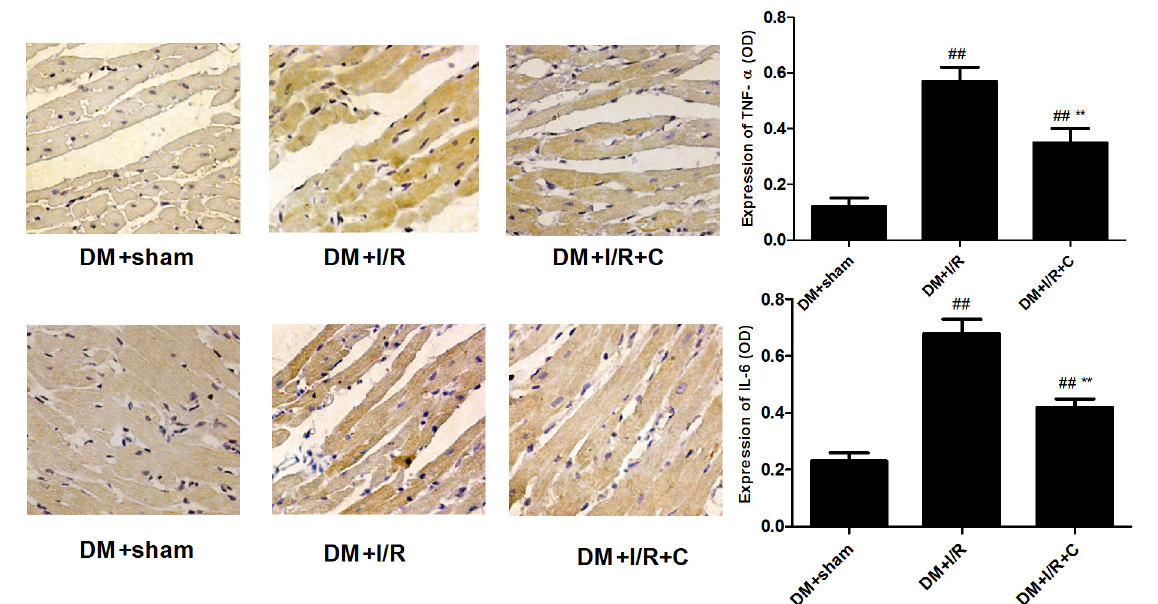
Figure 7. Effects of catalpol on protein expression of inflammatory cytokines ( TNF-α and IL-6 ) (400 ×). ## P < 0.01 versus the DM+sham group; ** P < 0.01 versus the DM+I/R group.